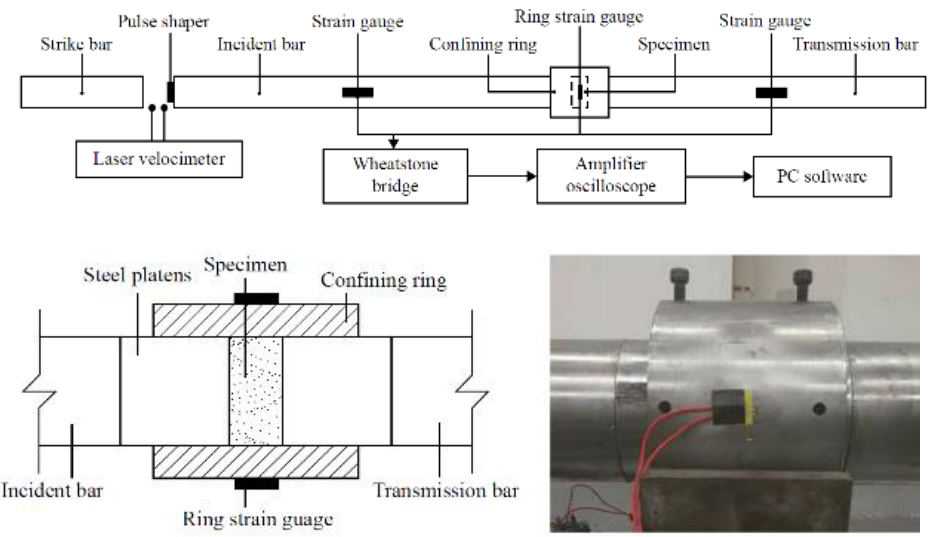
Figure 13. Schematic view of the SHPB test system and calcareous sand specimen (reprinted from Ref. [78]).